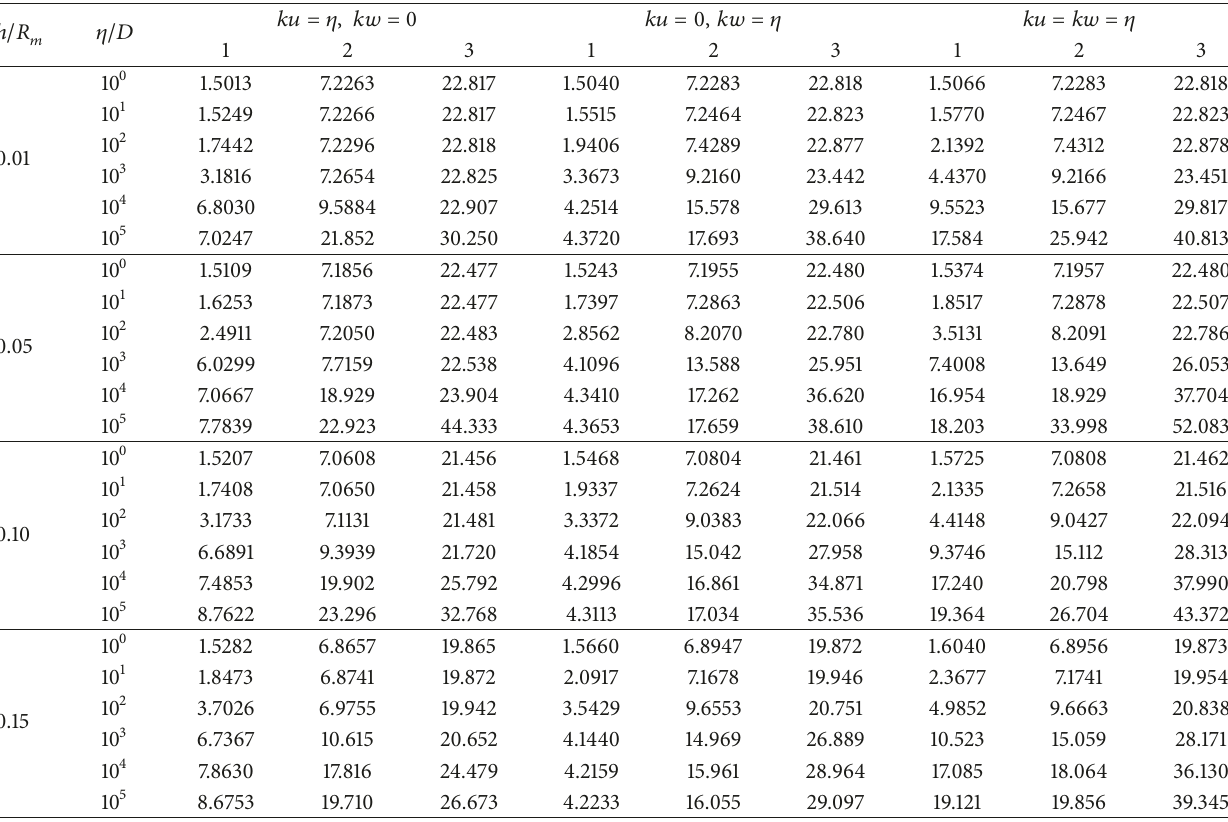
Table 6: Frequency parameters Ω for elastically supported circular beams with different thickness ratios and restraint rigidities ( 𝑅 𝑚 = 1 m, 𝜃 = 𝜋/2 ). 0